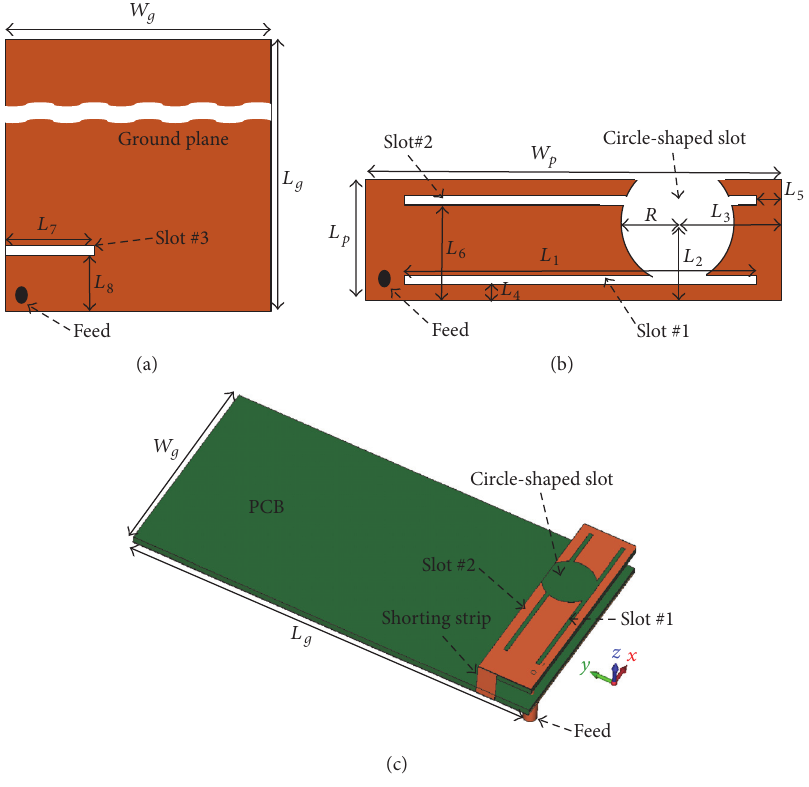
Figure 1: The geometry of the proposed PIFA: (a) ground plane, (b) radiating patch, and (c) the 3D view.